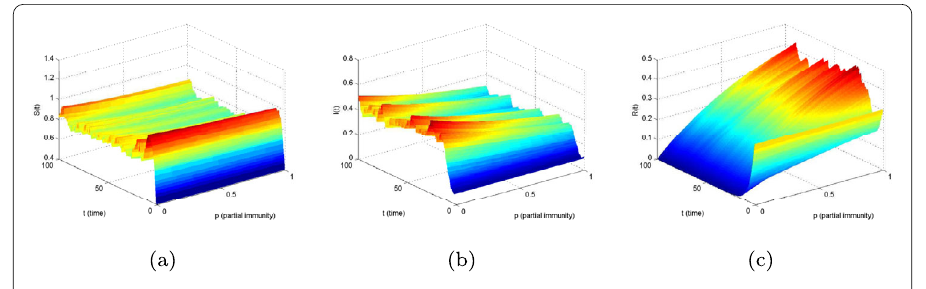
Figure 7 The effect of partial immunity p with respect to time t for compartments: ( a ) S , ( b ) I , and ( c ) R in model